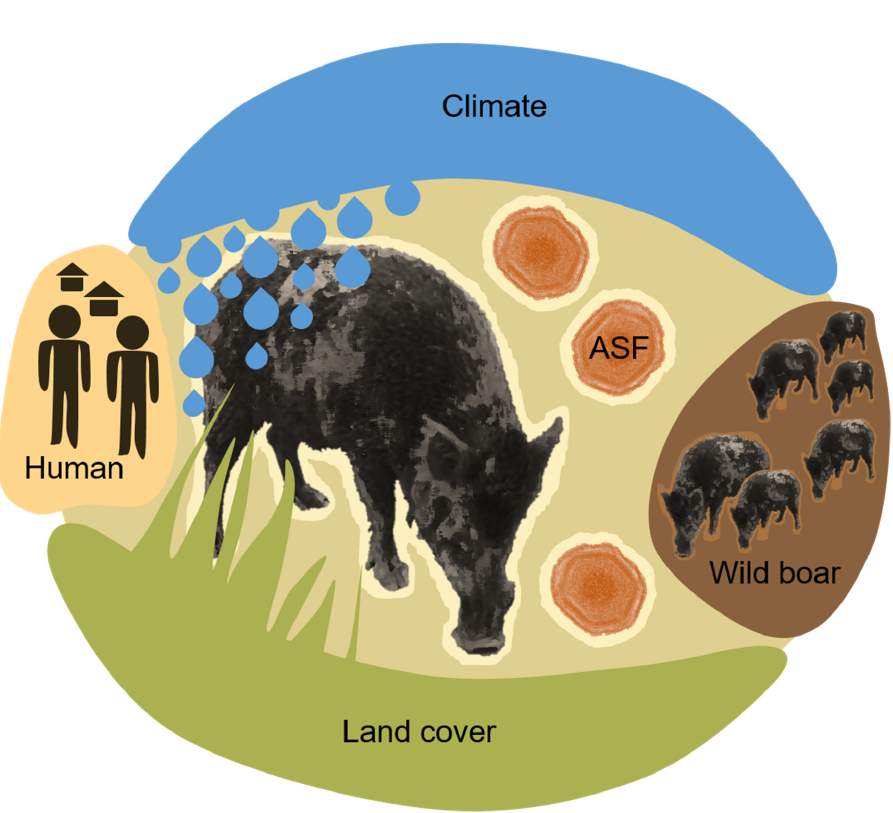
Figure 3. Environmental ASF risk factors for ASF in wild boar. Schematic drawing illustrating the reviewed environmental risk factor elements for ASF in wild boar. ASF—African swine fever.